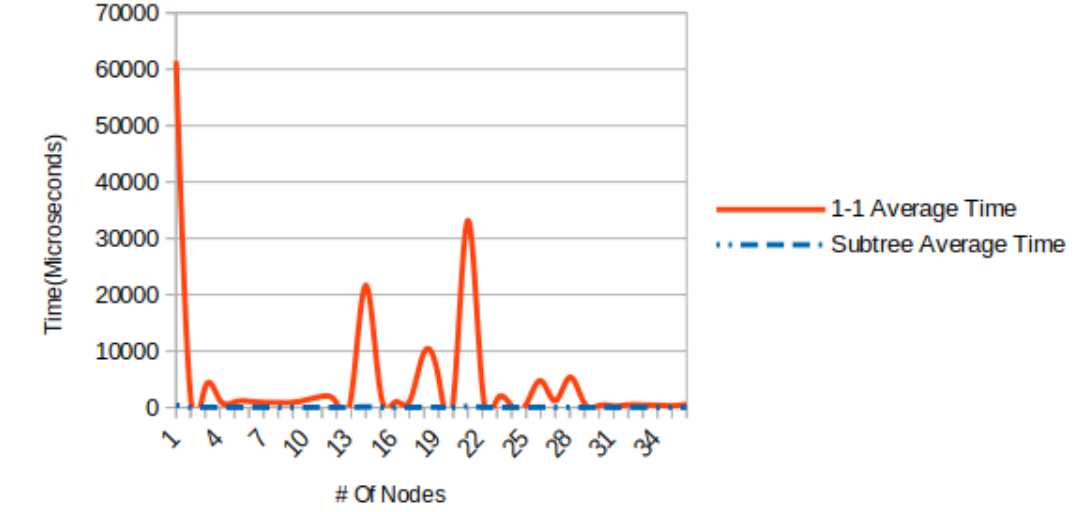
Figure 9. One-to-one vs. subtree time mapping comparison.